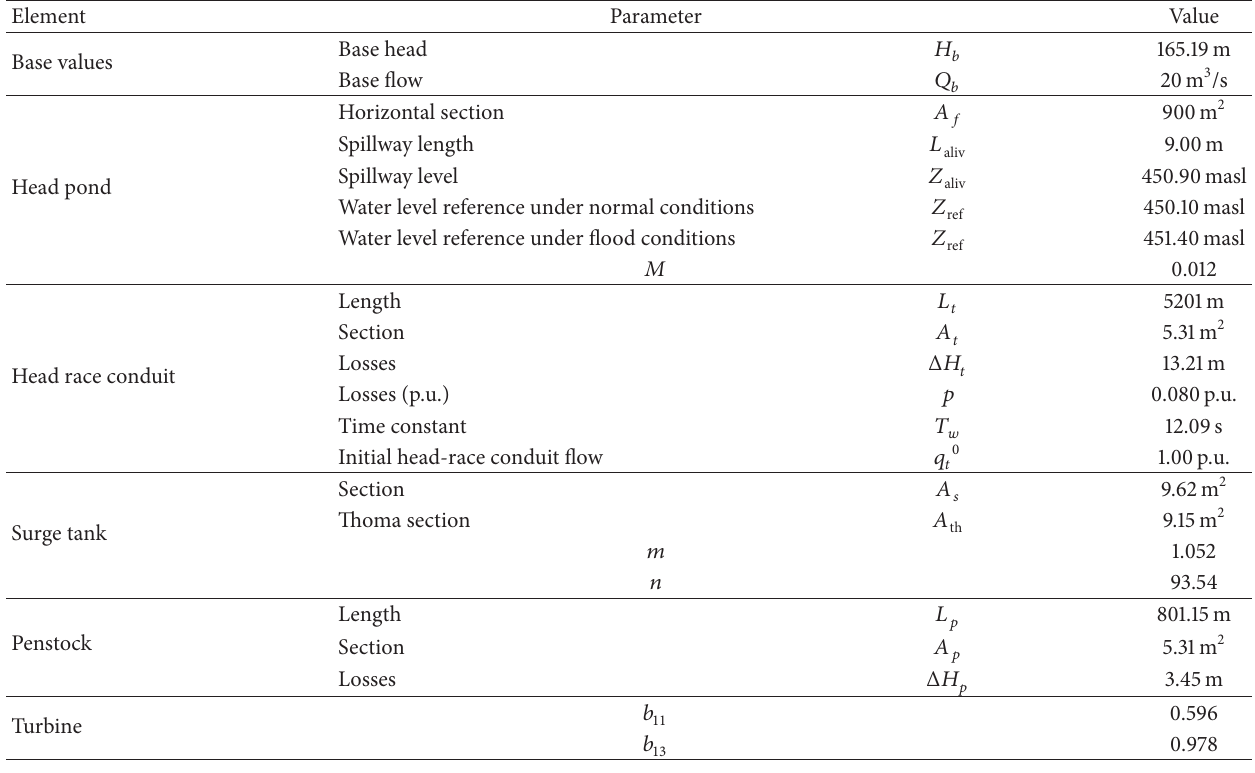
Table 1: Plant dimensions, parameters and base values.